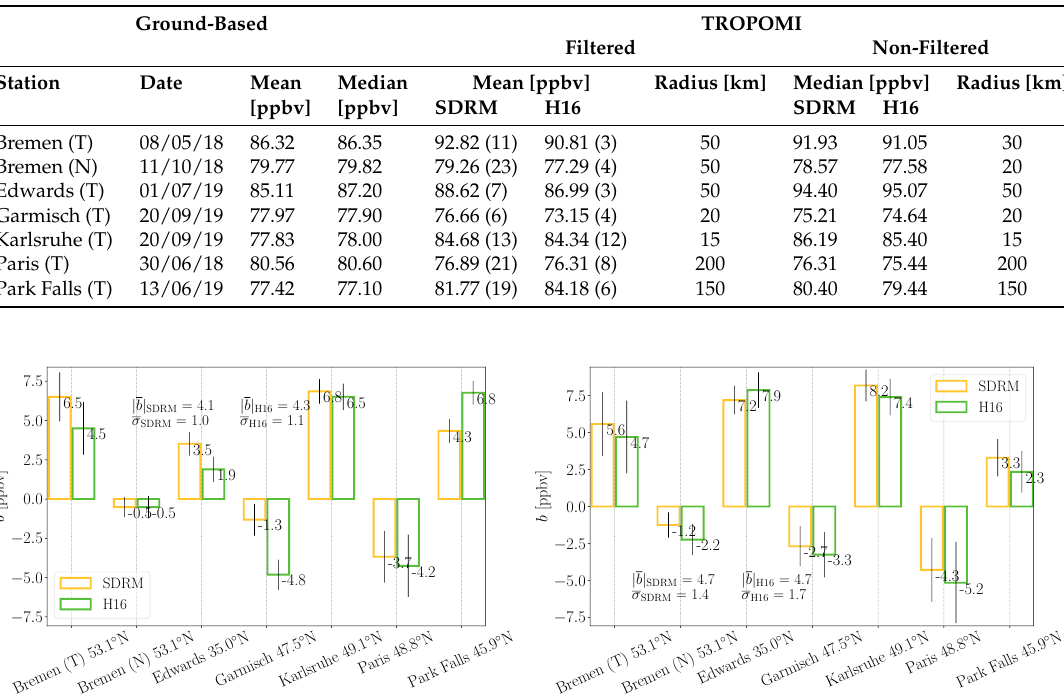
Figure 17. Differences of TROPOMI and TCCON/NDACC mean (left) and median (right) CO mole fractions from Table 2. Note that the mean was calculated upon the strictly filtered retrieval output, while the median includes all cloud-free